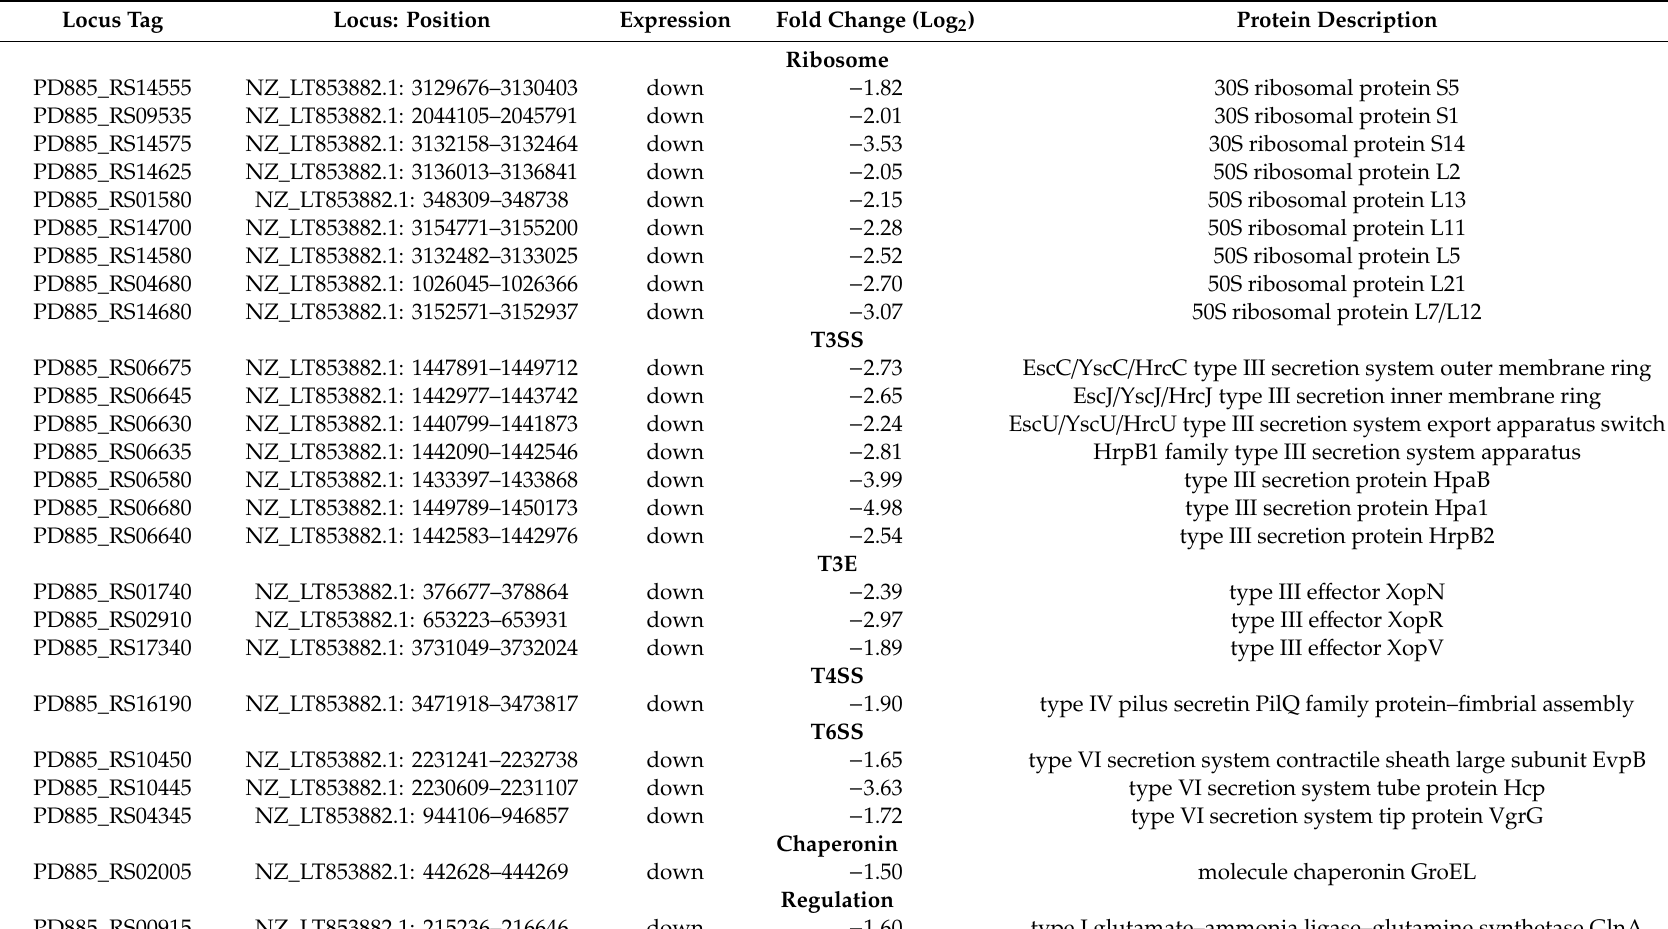
Table 2. Summary table of selected di ff erentially expressed Xanthomonas fragariae genes while interacting in planta with Fragaria × ananassa . A complete list of di ff erentially expressed genes is provided in Table S2. LPS,